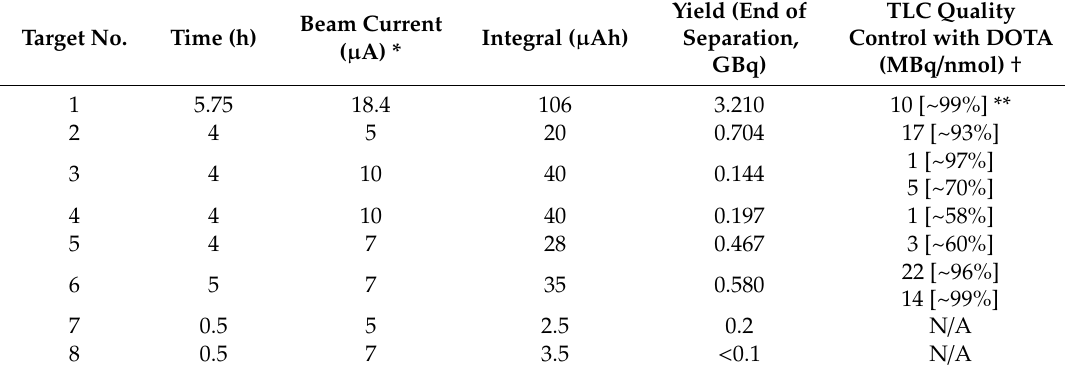
Table 2. Irradiation of 44 CaO targets (6 mm × 0.5 mm, ~30 mg) using 18 MeV protons at the Bern medical